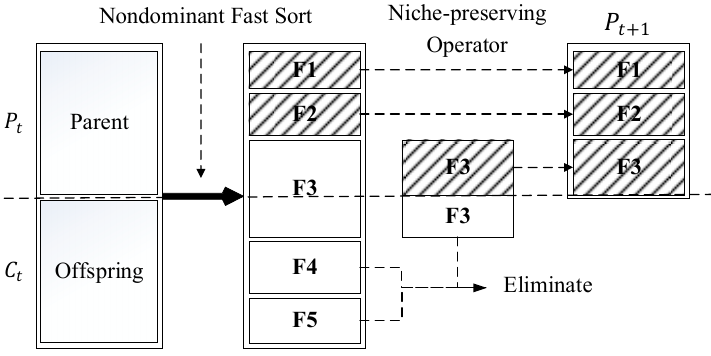
Figure 4. Illustration of the preselection operator.